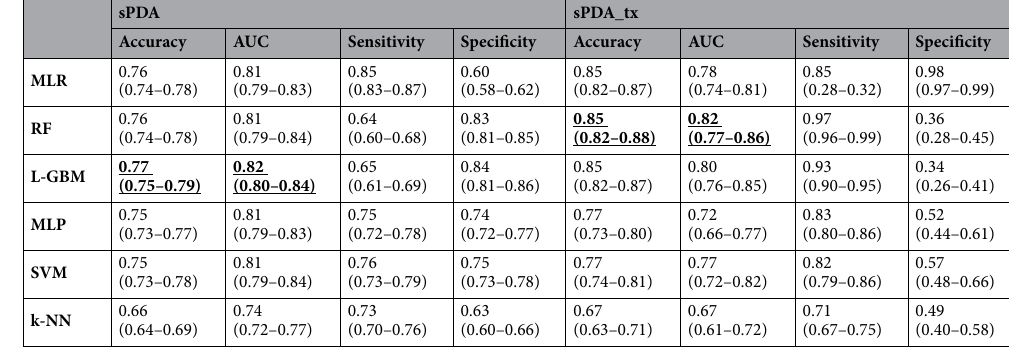
Table 2. Performance Metrics of the Algorithms for Predicting sPDA and sPDA_tx, mean values (95% CI). sPDA, symptomatic patent ductus arteriosus; sPDA_tx, symptomatic patent ductus arteriosus with any treatment; CI, confidence interval; AUC, area under the receiver operating characteristic curve; MLR, multilinear regression; RF, random forest; L-GBM, light gradient boosting machine; MLP, multilayer perceptron; SVM, support vector machine; k-NN, k-nearest neighbors. The underlined values denote the highest accuracy and AUC